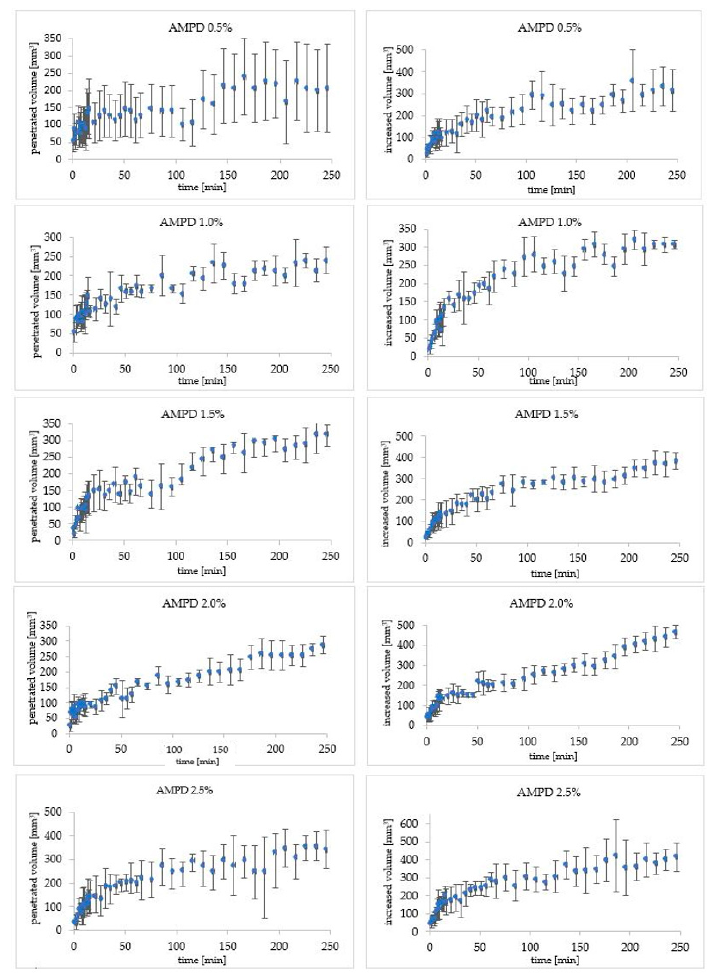
Figure 3. The course of changes in the increased and penetrated volume of model skin sebum under the influence of AMPD solutions for individual concentrations of AMPD solutions with the presentation of standard deviations (SD).